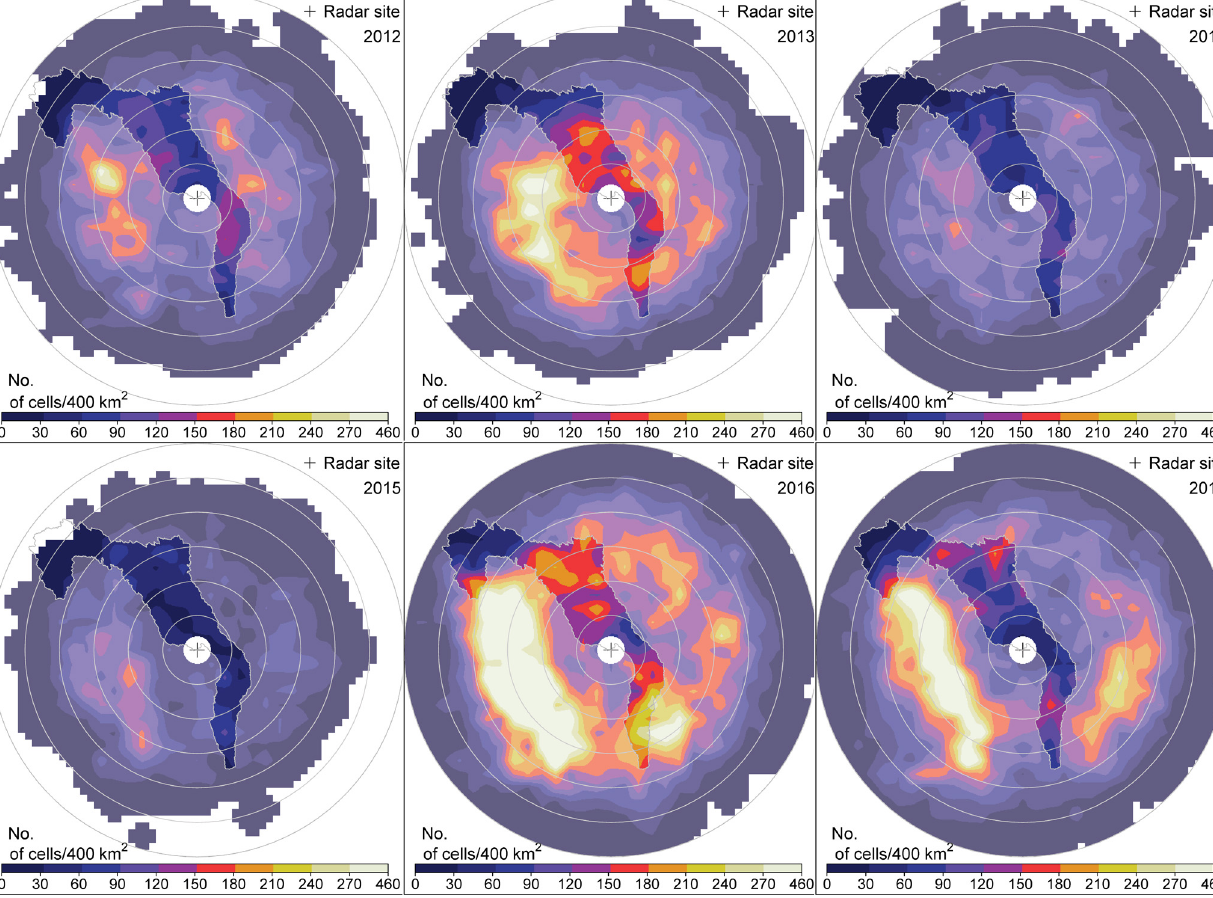
2017. In these maps, the area of the Prut River basin is high- lighted. For plotting reasons, the distribution was